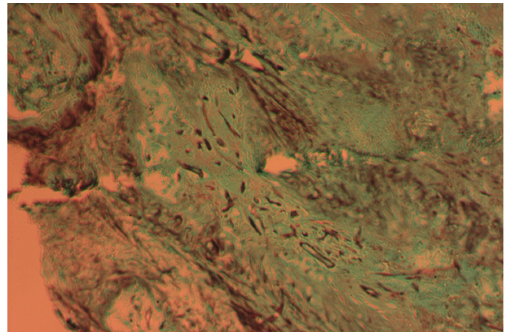
Figure 2: Biopsy with silver stain showing large pauciseptate hy- phae invading tissue.